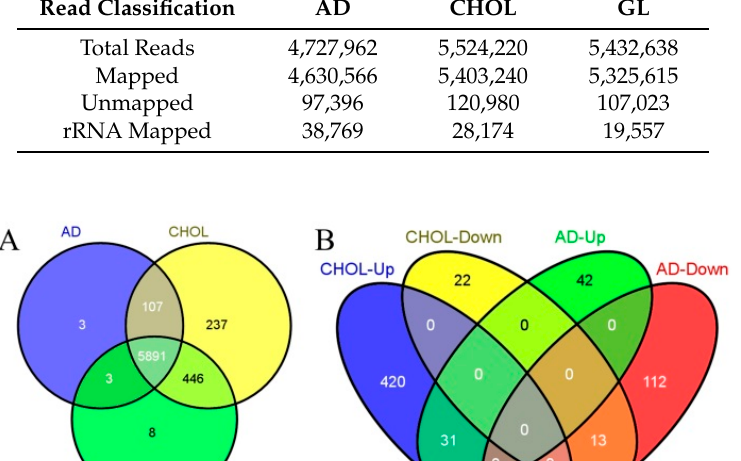
Table 1. RNA-Sequencing read mapping. Androstenedione (AD), cholesterol (CHOL) and glycerol (GL) correspond to three different conditions: 20 mL minimal medium plus with 1.75 mM (0.05%) androstenedione, 1.29 mM (0.05%) cholesterol and 5.47 mM (0.05%) glycerol respectively. RNA-Seq reads were mapped to the genome and rRNA of M. smegmatis MC 2 155 with Bowtie2 (v2.2.3) [31,32]. Read Classification